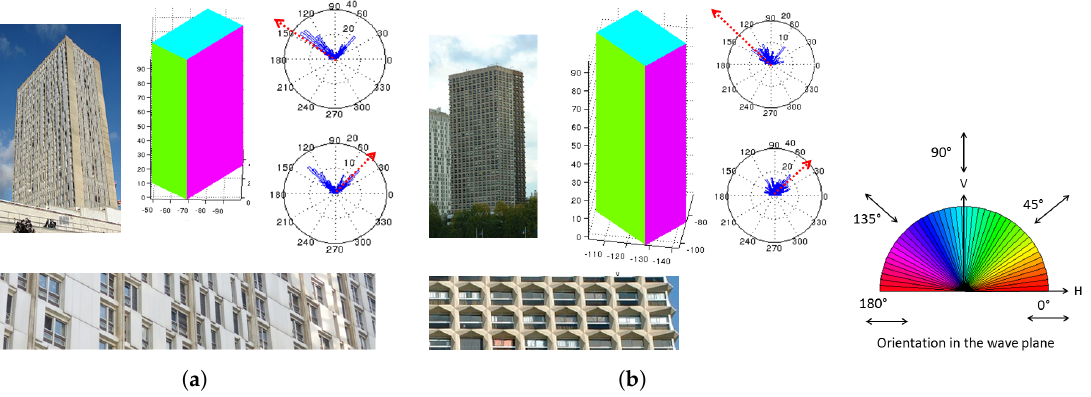
Figure 15. Images of the buildings and detail of its facade, orientaion of the facade from the ground truth and results of estimation of polarimetric orientation. ( a ) Keller Tower ( b ) Espace 2000 Tower.